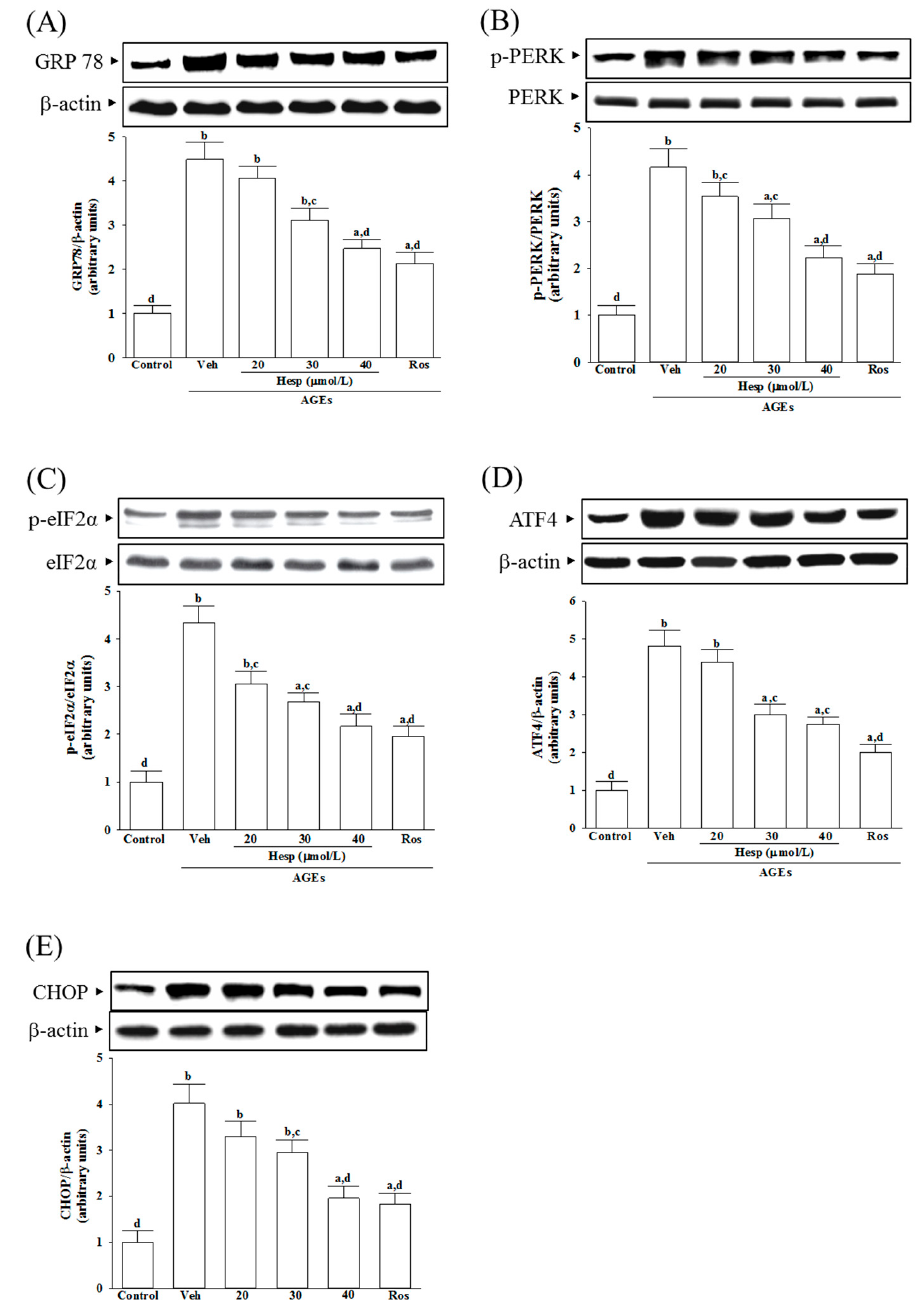
Figure 4. Investigation on the related molecules in ER stress in SH-SY5Y cells under AGE stimulation. Cells were received 1 h pretreatment with hesperetin (hesp; 20–40 µ mol/L) or rosiglitazone (Ros; 10 µ mol/L), continued to 24 h AGE (200 µ g/mL) exposure. A representative Western blot analyzed the relative levels of ( A ) 78-kDa glucose-regulated protein(GRP78), ( B ) p-protein kinase-like endoplasmic reticulum kinase(PERK), PERK, ( C ) p-eukaryotic initiation factor (eIF) 2 α , eIF2 α , ( D ) activating transcription factor (ATF)4, and ( E ) C/EBP homologous protein (CHOP). The band densities for protein were normalized to the β -actin band intensity. The ratio of phosphoprotein to total protein in PERK (p-PERK/PERK) and eIF2 α (p-eIF2 α /eIF2 α ) is also shown. The results are presented as the mean ± SD of five independent experiments performed triplicate (n = 5). a p < 0.05 and b p < 0.01 when compared to the data from the untreated control group (control). c p < 0.05 and d p < 0.01 when compared to the data from the vehicle (Veh)-treated cells. The ratio of phosphoprotein to total protein in PERK (p-PERK/PERK) and eIF2 α (p- eIF2 α /eIF2 α ) are 4.1- and 4.3-fold more significant in SH-SY5Y cells under AGE induction